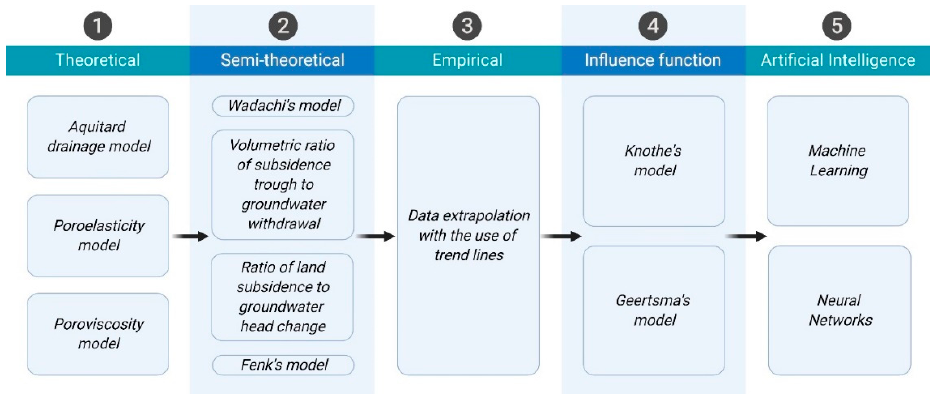
Figure 6. Schematic classification of methods used to predict land subsidence induced by groundwater over-exploitation.